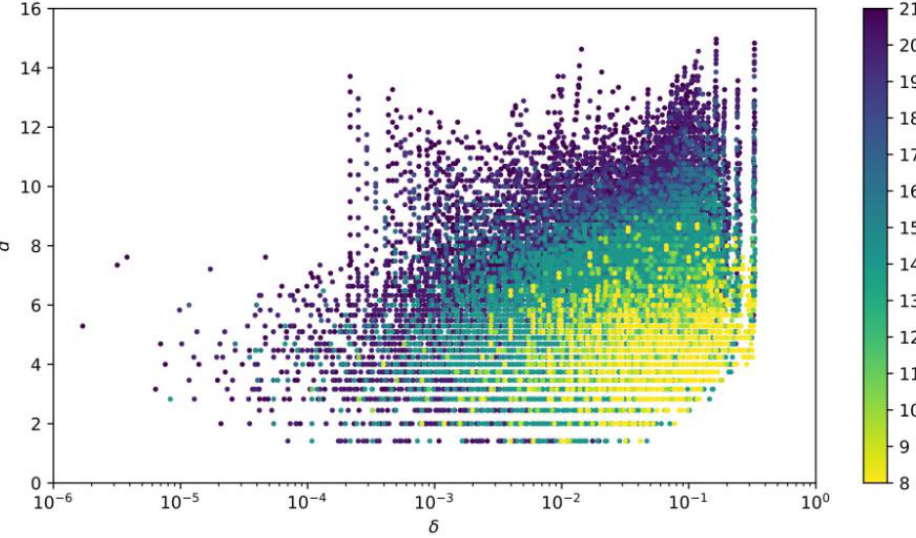
Figure 2. Color online. Scatter plot showing, for each detuned triad, the detuning δ versus the distance d to the closest resonant triad. The color of each point indicates n max , the largest n found amongst all the six modes in the detuned triad and its closest resonant triad. The plot can be thought of as a layer of each color, with layers corresponding to low n max , appearing in front of layers corresponding to high n max . The number of layers is limited by the domain size N = 21 .